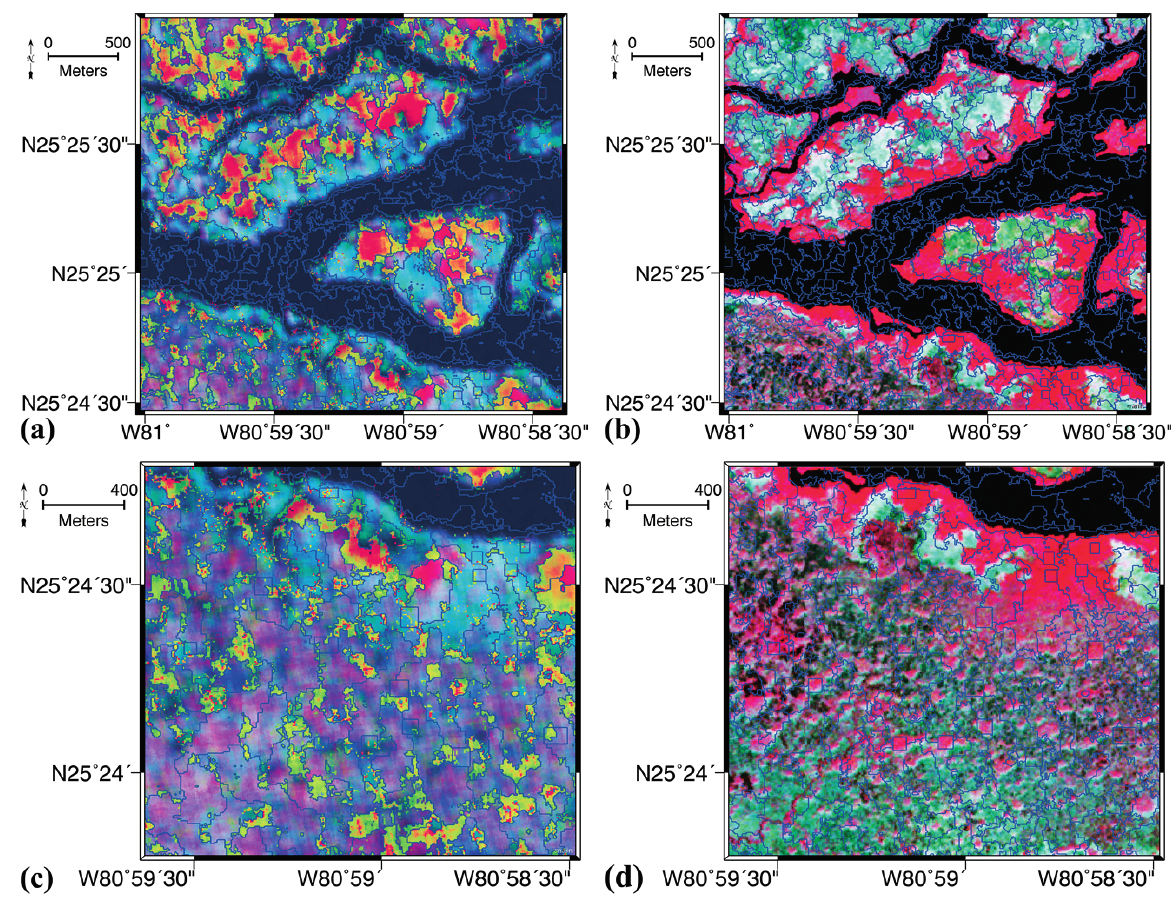
Figure 6. Segmentation results of type S displayed on the TSX image using false-color composite image decomposition layers (red = double bounce scattering, green = volume scattering, and blue = single bounce scattering in [a] and [c]) and on the RapidEye image using false-color composite images (red = near infrared, green = red visible, and blue = green visible bands in [b] and [d]); ( a , b ) are near tidal canals; ( c , d ) are near inland